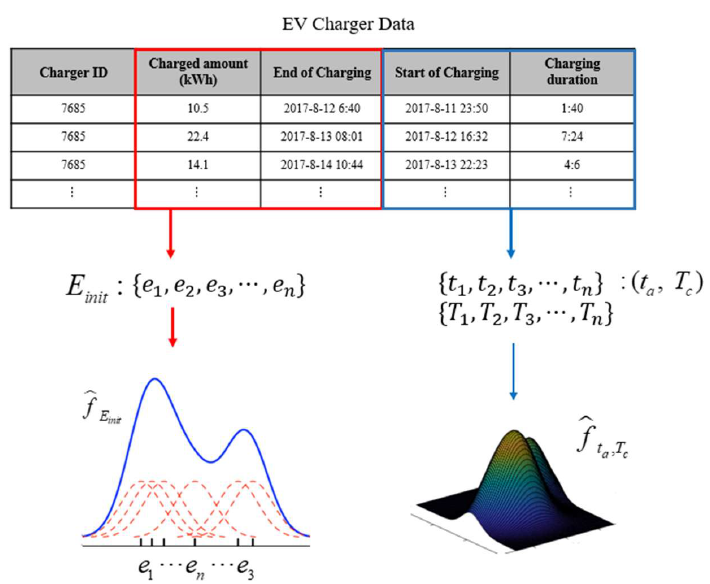
Figure 3. Data-driven kernel density estimation (KDE) regarding initial energy E init in the battery when an EV arrives, and the tuple of EV arrival time and charging duration ( t a , T c ) .